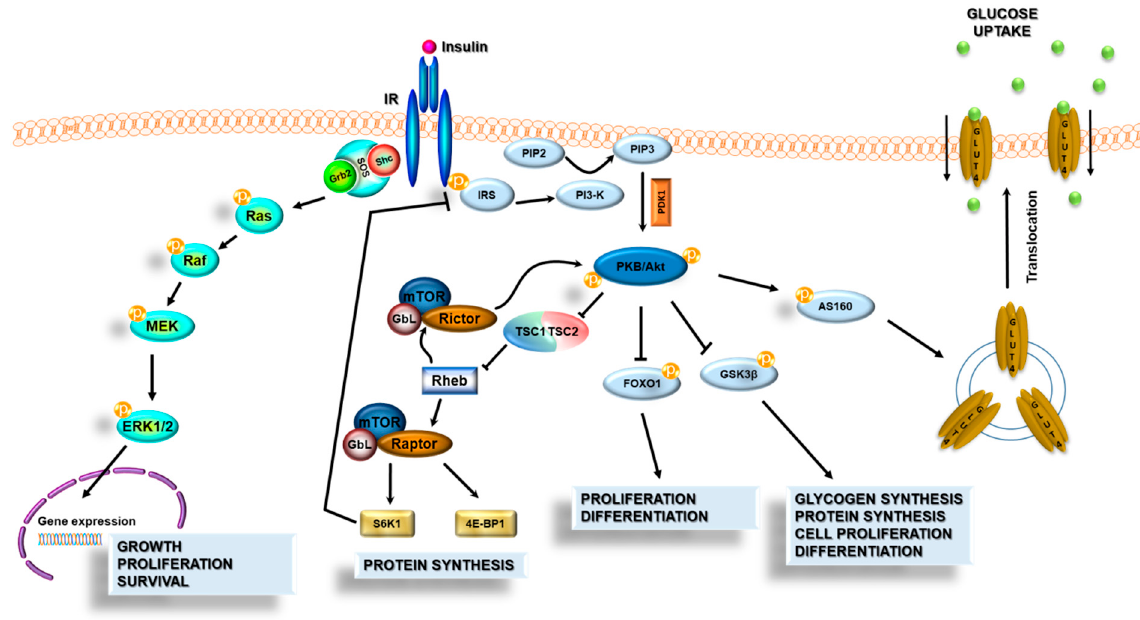
Figure 1. Scheme of the insulin signal transduction pathways. Insulin acts on target cells through its specific insulin membrane receptor (IR). IR consists of two α subunits located outside the cell membrane and two β subunits anchored to the cell membrane. Activation of the IR causes autophosphorylation of the β subunits, which recruit the next cellular proteins. Insulin activates two major signal transduction pathways: the PI3K-PKB/Akt-dependent pathway and the MAPK (mitogen-activated protein kinase) kinase pathway.